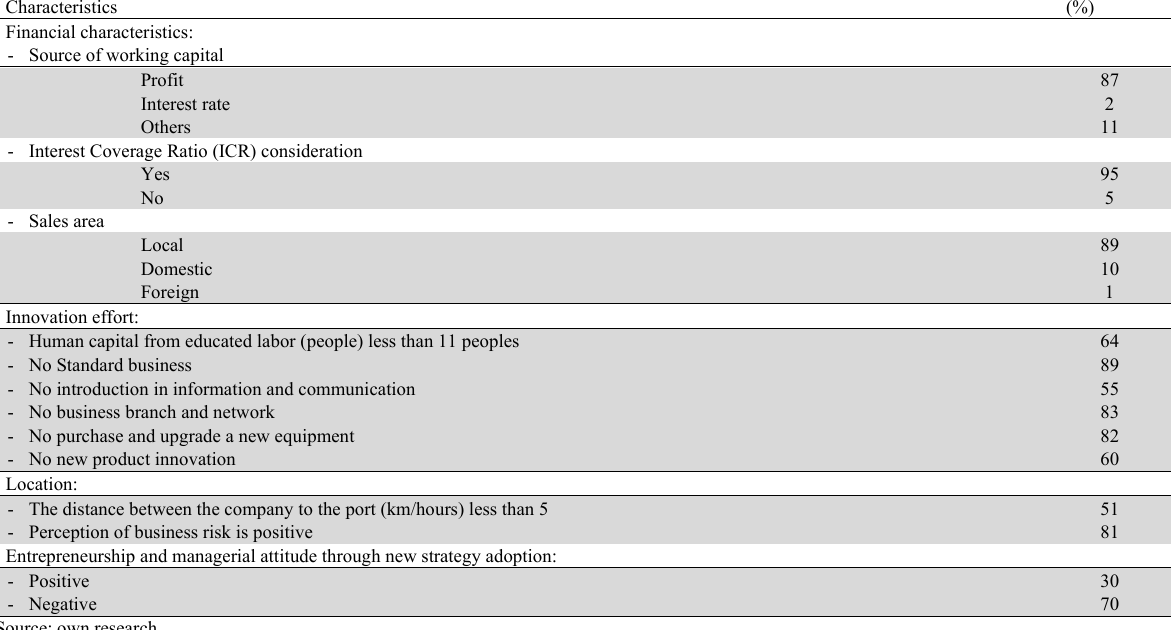
Characteristics of financial, innovation effort, location, and entrepreneurship and managerial attitude through new strategy adoption